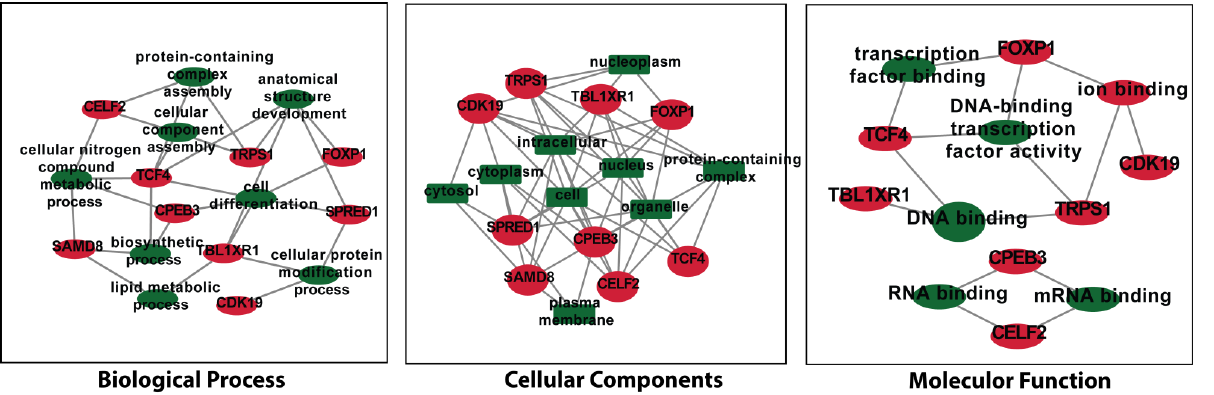
Figure 9. GO of the NSCLC associated key genes ( CPEB3 , SAMD8 , FOXP1 , TRPS1 , TCF4 , TBL1XR1